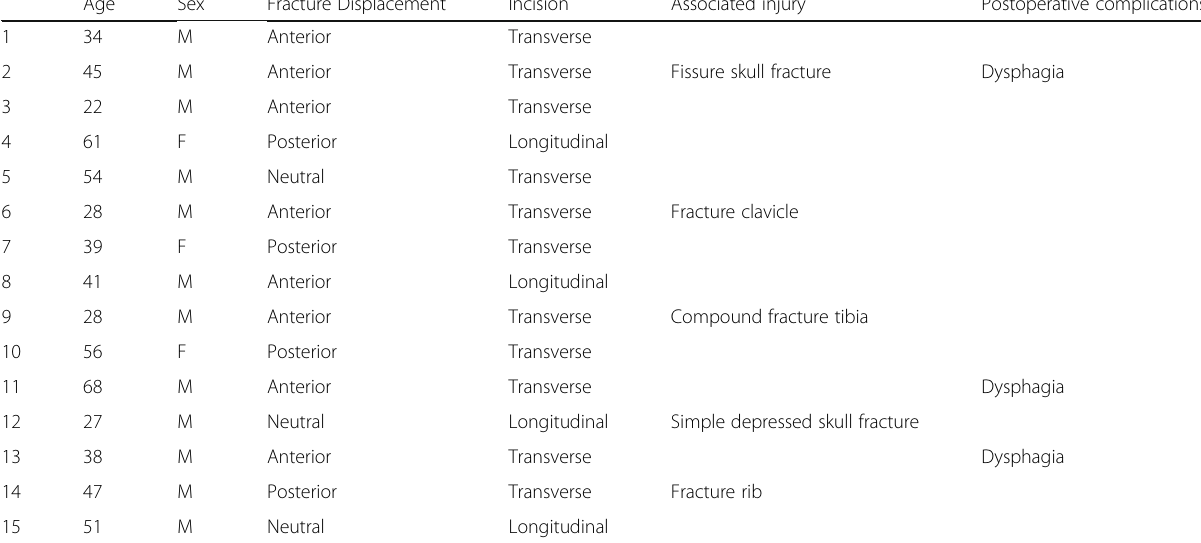
Table 1 Summary of